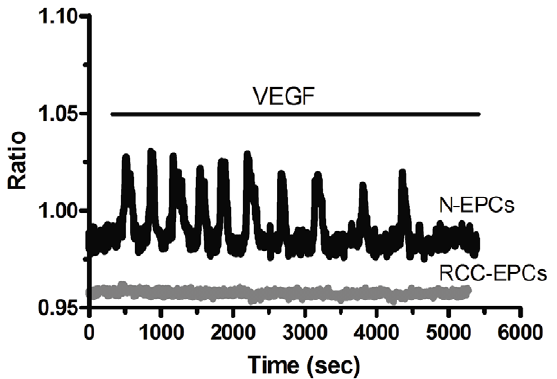
Figure 12. VEGF does not induce Ca 2 + oscillations in endothe- lial progenitor cells isolated from patients affected by renal cellular carcinoma. VEGF (10 ng/ml) elicits a burst of intracellular Ca 2 + waves in N-EPCs (black tracing), but not in RCC-ECFCs (grey tracing). The Ca 2 + traces are representative of 165 N-EPCs and 148 RCC- EPCs, respectively, harvested from three different